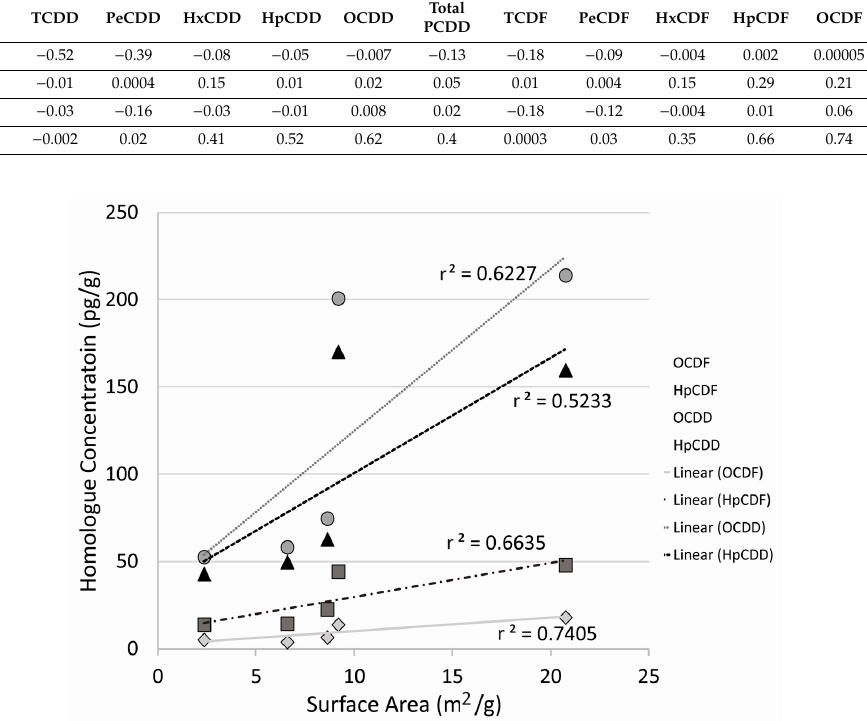
Figure 17. Positive relationship between the concentration of four homologues and mineral surface area in sample DF 46–48. This is the only homologues that show a correlation between homologue concentration and surface area from the fractionated size